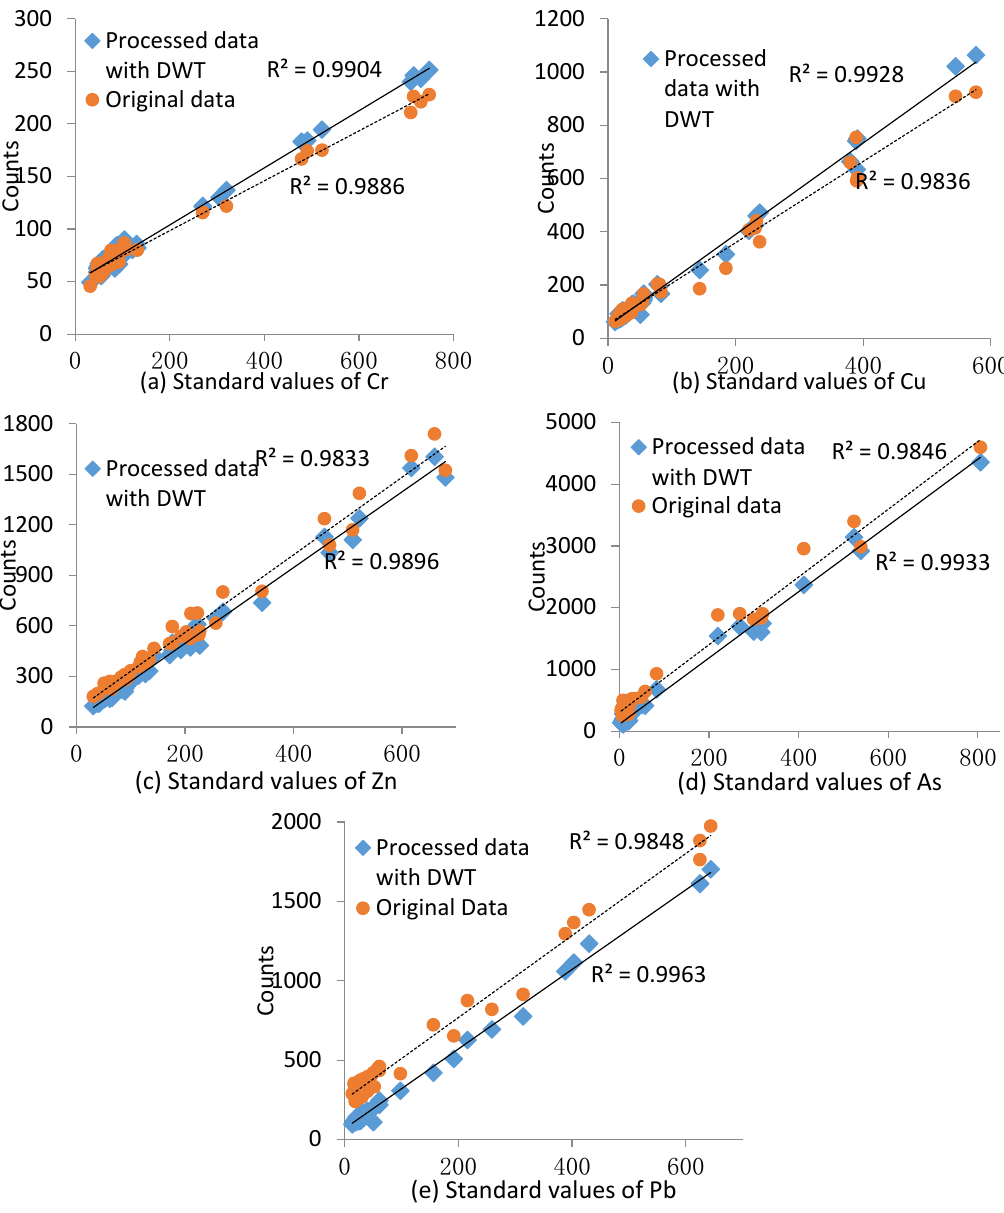
Figure 6. Calibration curves for Cr ( a ), Cu ( b ), Zn ( c ), As ( d ) and Pb ( e ). Spectral data were pre-processed with DWT.